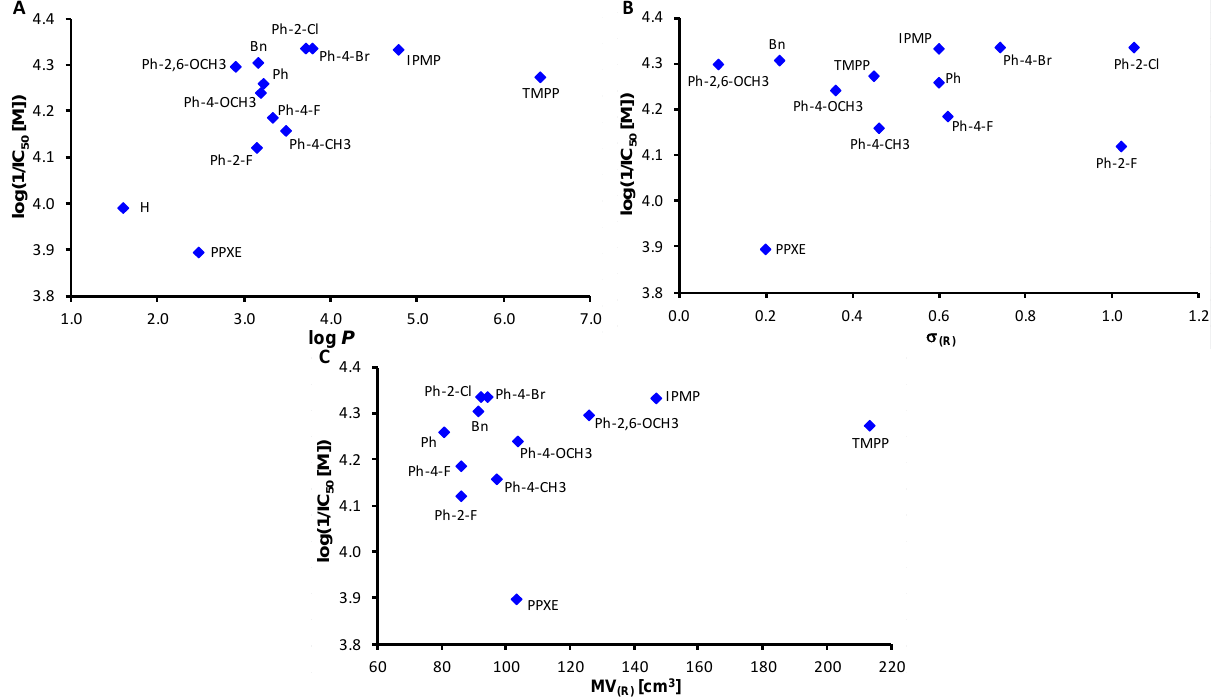
Figure 2. Dependences of AChE-inhibiting activity log(1/IC 50 (M)) of all compounds 1 – 13 on lipophilicity expressed as log P ( A ), electronic σ parameters and bulkiness expressed as molar volume (MV) of whole O -part of individual esters ( B , C ). IPMP = 2-isopropyl-5-methylphenyl, TMPP = 4-(2,4,4-trimethylpentan-2-yl)phenyl, PPXE = 2-propoxyethyl.